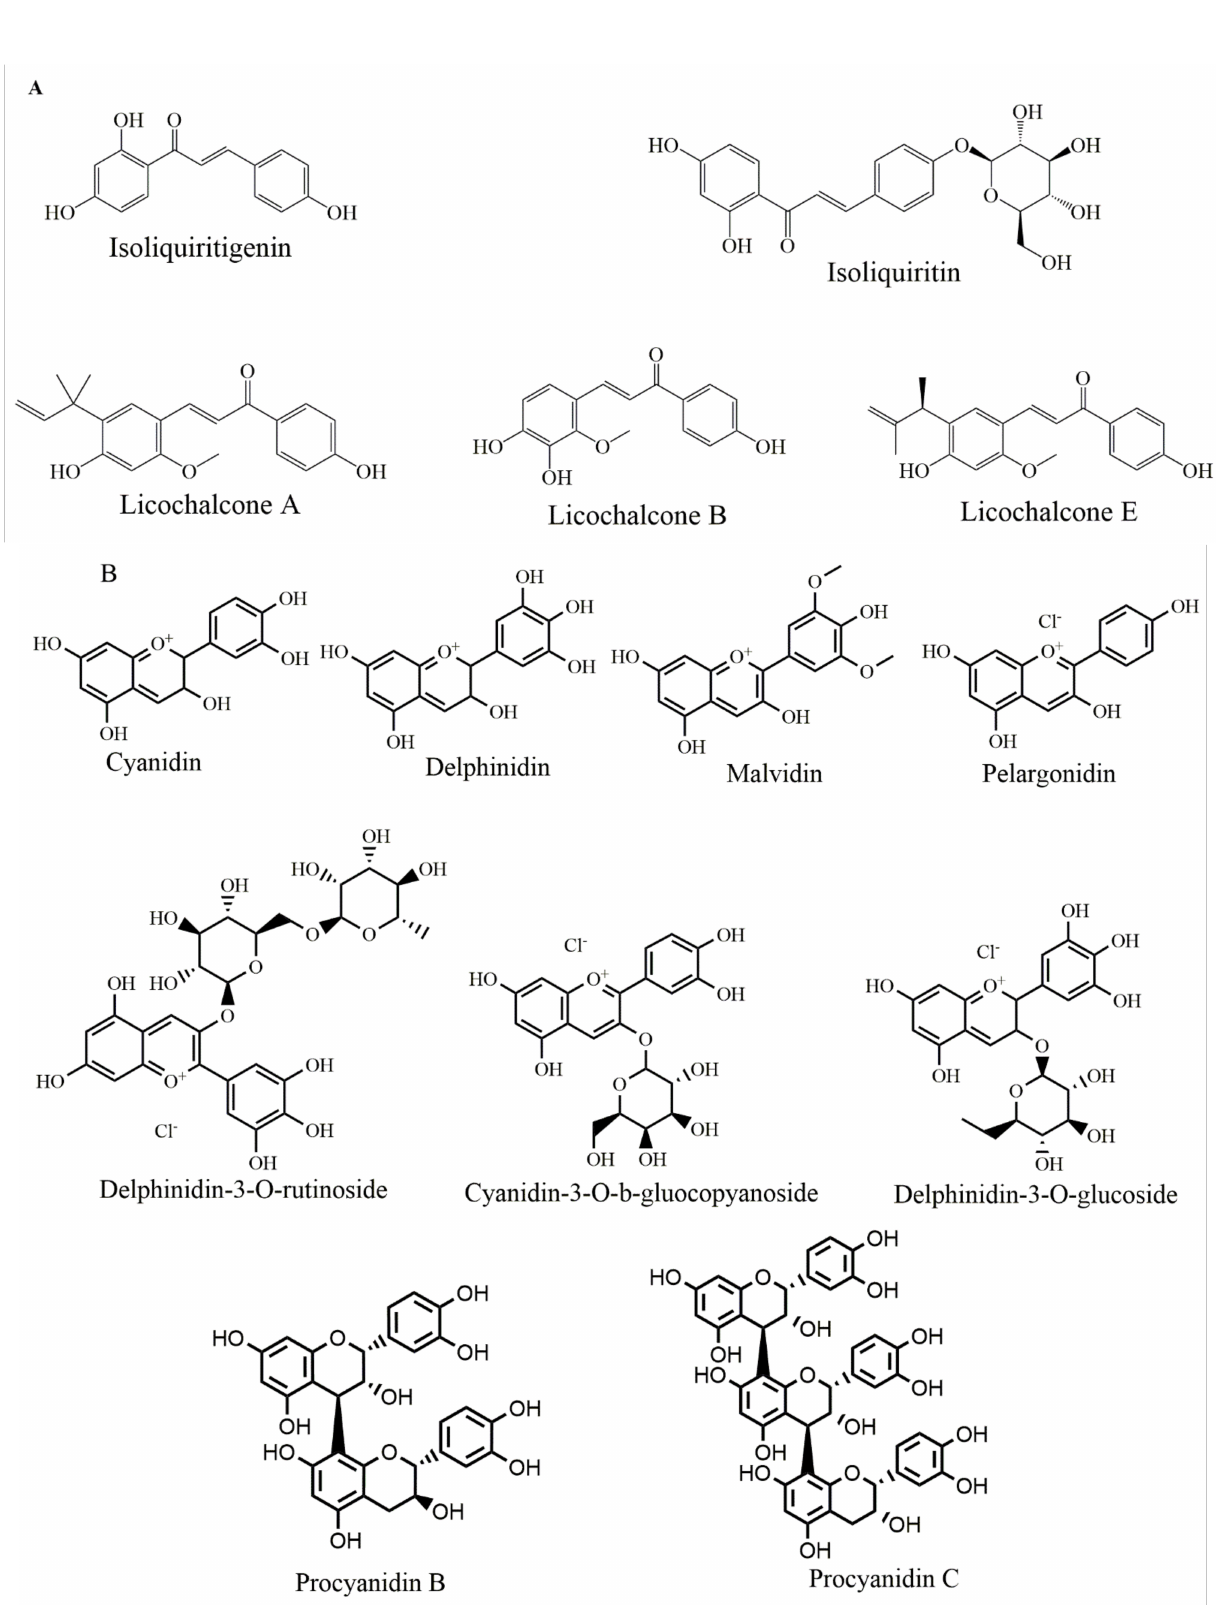
Figure 5. Selected chemical structures of chalcones ( A ), anthocyaninsx and catechins ( B ) that target Bcl-2 in the p53